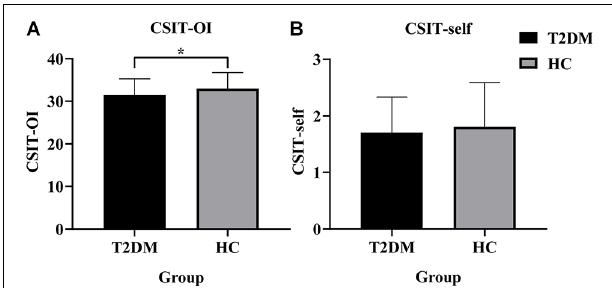
FIGURE 1 | Histogram of CSIT scores for all participants in this study. (A) The CSIT-OI scores of patients with T2DM were lower than HC (* P < 0.05). (B) There was no difference in the CSIT-self scores of the two groups ( P > 0.05). T2DM, Type 2 Diabetes Mellitus; HC, Healthy Controls; CSIT, Chinese Smell Identification Test; OI, olfactory identification.